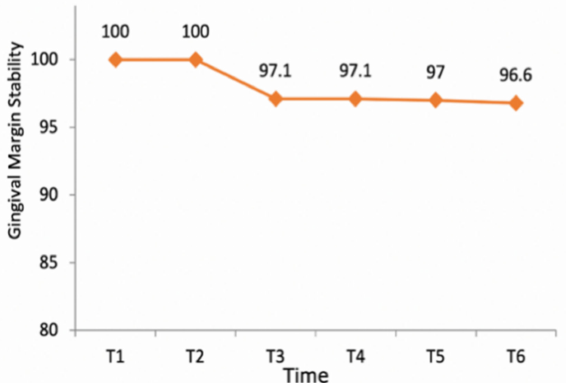
Figure 12. Graph illustrating gingival margin stability over the follow-up period. Note that after the fourth year, stability fell slightly, due to a reduction in the sample size for reasons other than gingival recession (i.e., loss of patients from the follow-up or restoration